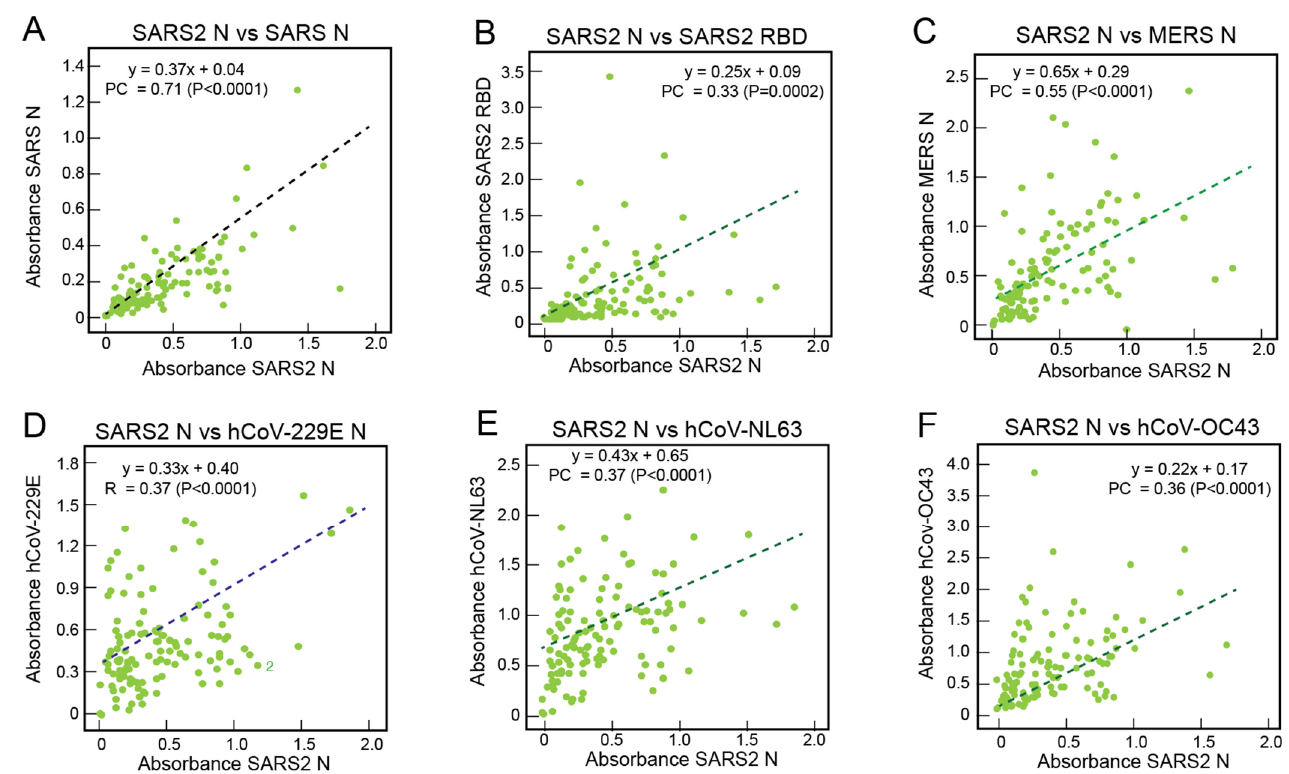
Figure 3. Correlations of the serological responses of Sierra Leoneans to coronavirus antigens. Binding of IgG in serum or plasma samples (1:100 dilution) from Sierra Leoneans was quantified using ELISA coated with recombinant coronavirus proteins. Reactivity to SARS-CoV-2 N was compared to other coronavirus proteins in each panel: ( A ) SARS-CoV N, ( B ) SARS-CoV-2 RBD, ( C ) MERS-CoV-N, ( D ) hCoV-229E N, ( E ) hCoV-NL63 N, and ( F ) hCoV-OC43 N. Dotted lines are linear regression plots of seroreactivity of SARS-CoV-2 N versus other recombinant coronavirus proteins. PC = Pearson’s correlation.